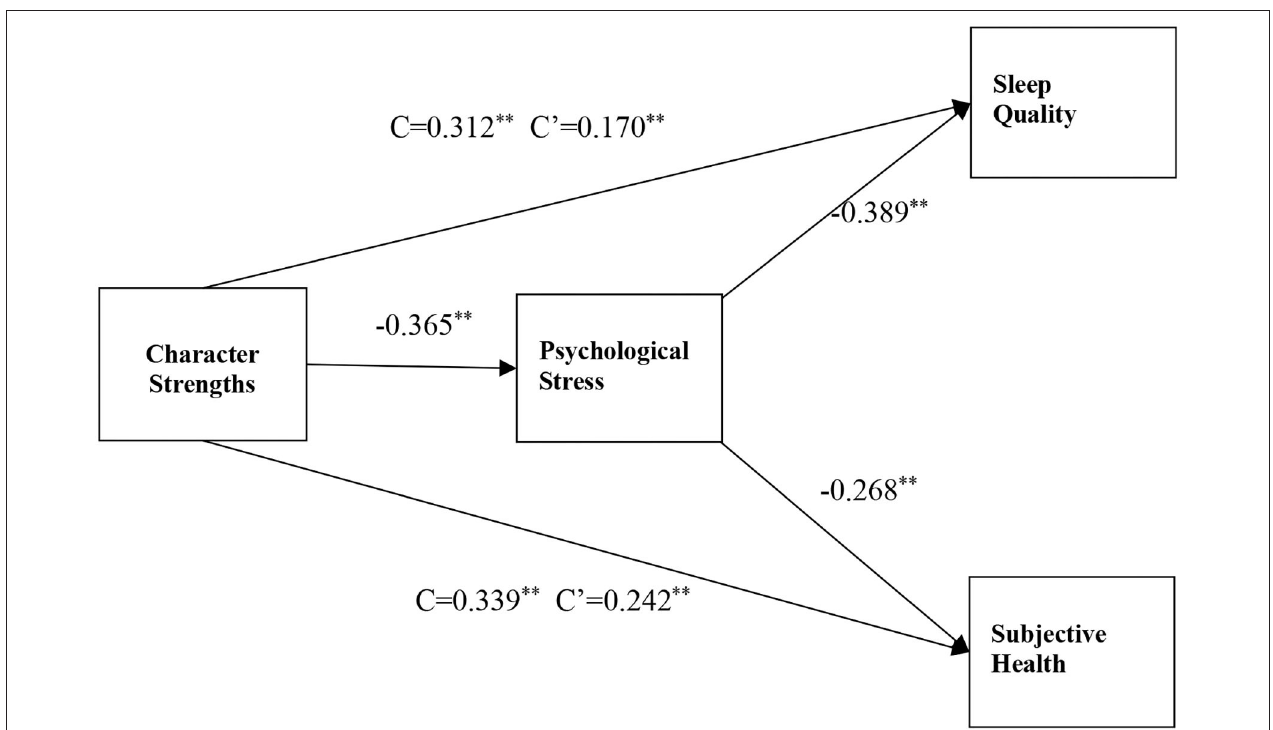
FIGURE 1 | Modified model and standardized path coefficients. * p < 0.05, ** p <